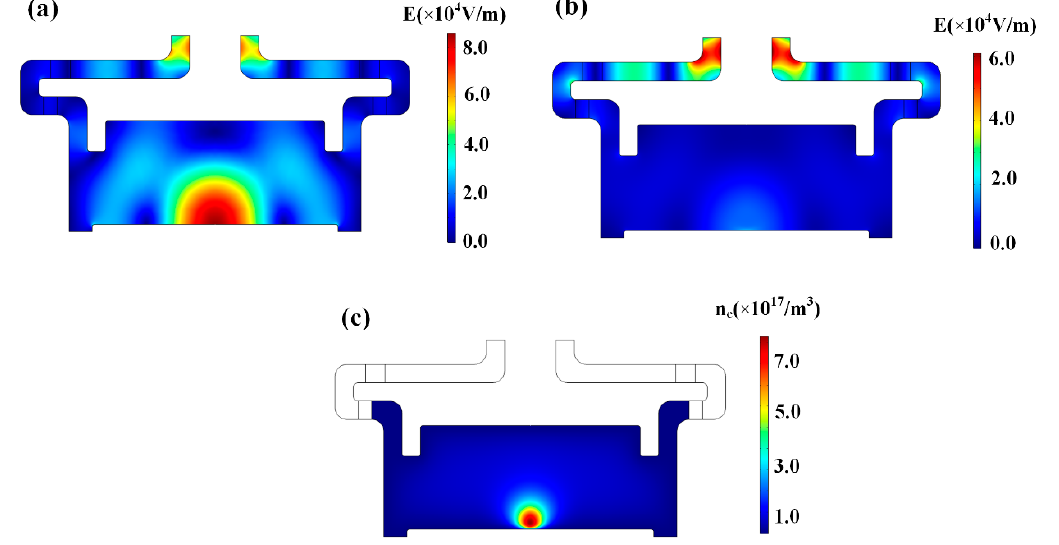
Figure 2. Simulation results of the ( a ) vacuum electric field, ( b ) microwave electric field with consideration of plasma excitation, and ( c ) electron-density distribution in the cylindrical cavity.